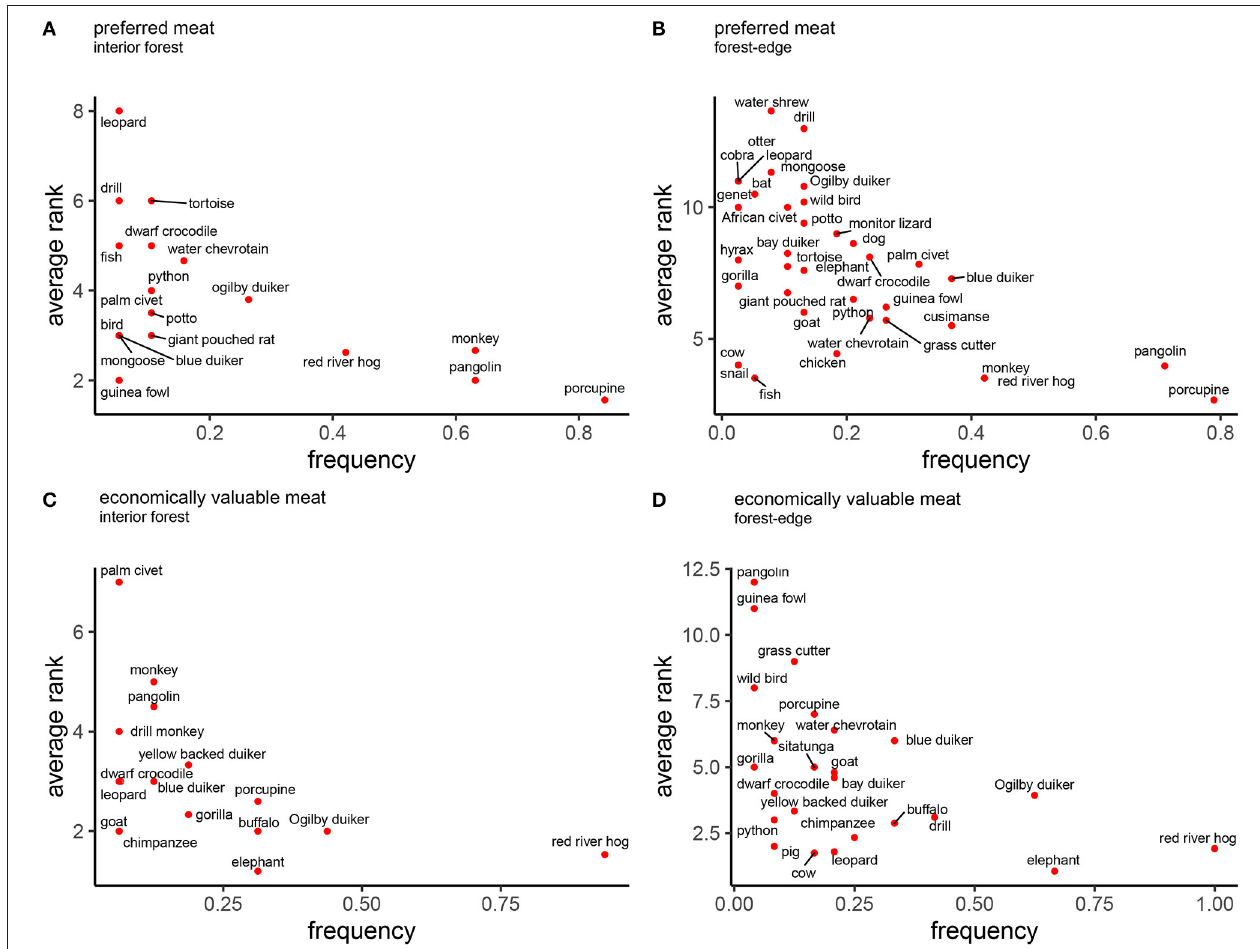
FIGURE 4 | Salience of animals as food and economic resource, by forest proximity. Salience plots of the frequency an animal was mentioned (x-axis) and the average rank assigned to each animal (y-axis) during free-listing exercises with key informants. Plots show preferred animals (A,B) and most economically important (C,D) animals in the lower right-hand corner, comparing deep (A,C) and marginal (B,D) forest